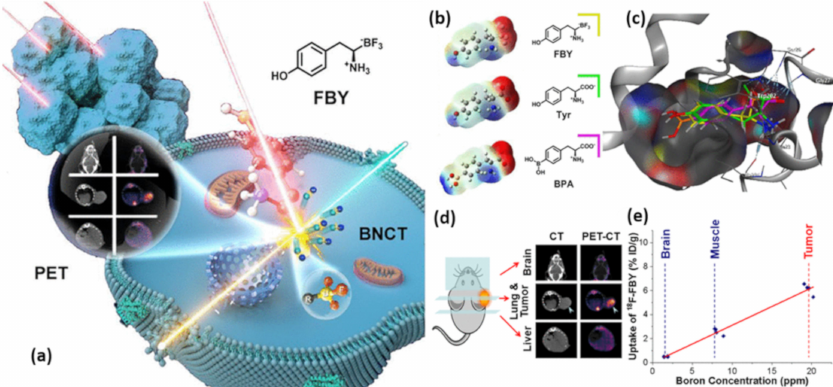
Figure 9. ( a ) The schematic presentation of the method reported by Ref. [111]. ( b , c ) The computational studies of FBY, Tyrosine, and BPA. ( d ) CT and PET-CT images of the brain, lung tumor and liver retention of [ 18 F]FBY. ( e ) Correlation between standard uptake value (SUV) of organs and boron concentration of [ 18 F] FBY. (adopted from Ref.